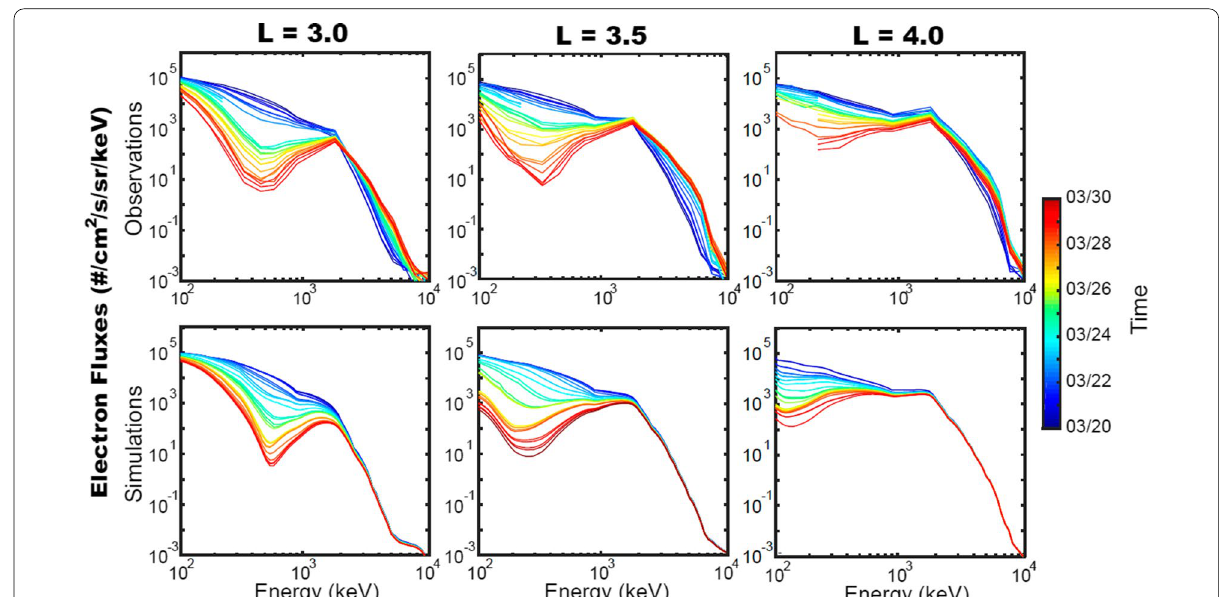
Fig. 7 Comparison of Fokker–Planck simulations (bottom row of three panels) with observations of energetic electron spectra made in March 2015 by the RBSP spacecraft. The color coding indicates the dates when data were acquired from 20 to 30 March 2015 ( Adapted from Zhao et al.